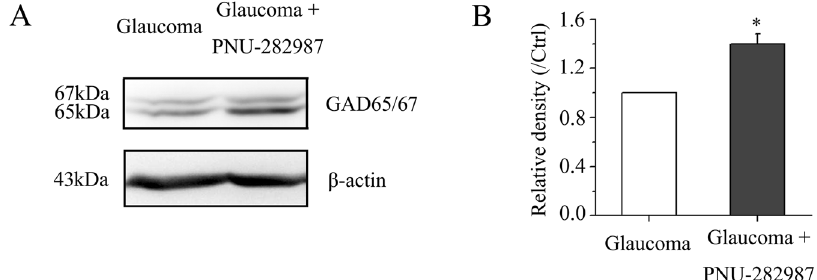
Figure 6. PNU-282987 prevents the reduction in GAD65/67 protein expression caused by chronic ocular hypertension. ( A ) Western blotting showing the effects of PNU-282987 on GAD65/67 protein expression in glaucomatous retina. The full-length blots are presented in Supplementary Figure S1. ( B ) Densitometric analysis of GAD65/67 confirming that PNU-282987 upregulates GAD65/67 protein expression in glaucomatous retina ( n = 6). * p < 0.05 (Student’s paired t test). GAD65/67 expression was normalized to β -actin and is shown relative to its expression in control retinas. The results in B are expressed as the mean ± SE. GAD, glutamic acid